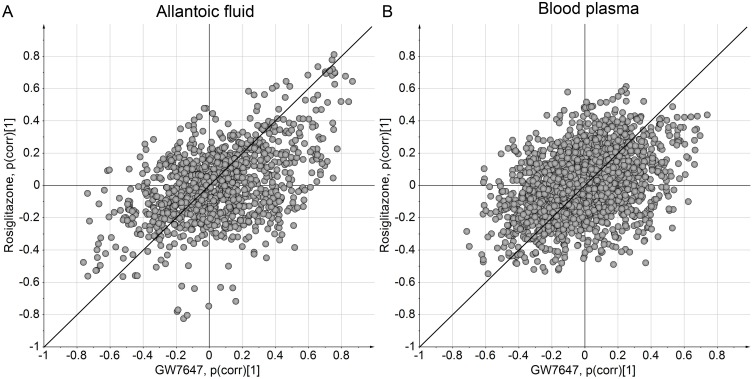
SUS-plots (Shared and Unique Structures) of GW7647 vs rosiglitazone OPLS-DA models.In the SUS-plot, the correlation from the predictive component of each of the two compared models is plotted against each other. The x-axis indicates change in concentration caused by GW7647 and the y-axis indicates change caused by rosiglitazone (upregulation at positive values and downregulation at negative values, compared to control). Thus, metabolites close to the diagonal running from the lower left corner to the upper right corner are affected by both GW7647 and rosiglitazone in a similar way, i.e. variables at the extremes of this diagonal are upregulated (top right) or downregulated (lower left) by both compounds. The plots show that many metabolites are affected in the same direction by the two compounds but there are also metabolites that are affected by only one of the compounds or affected in the opposite direction by the two compounds.